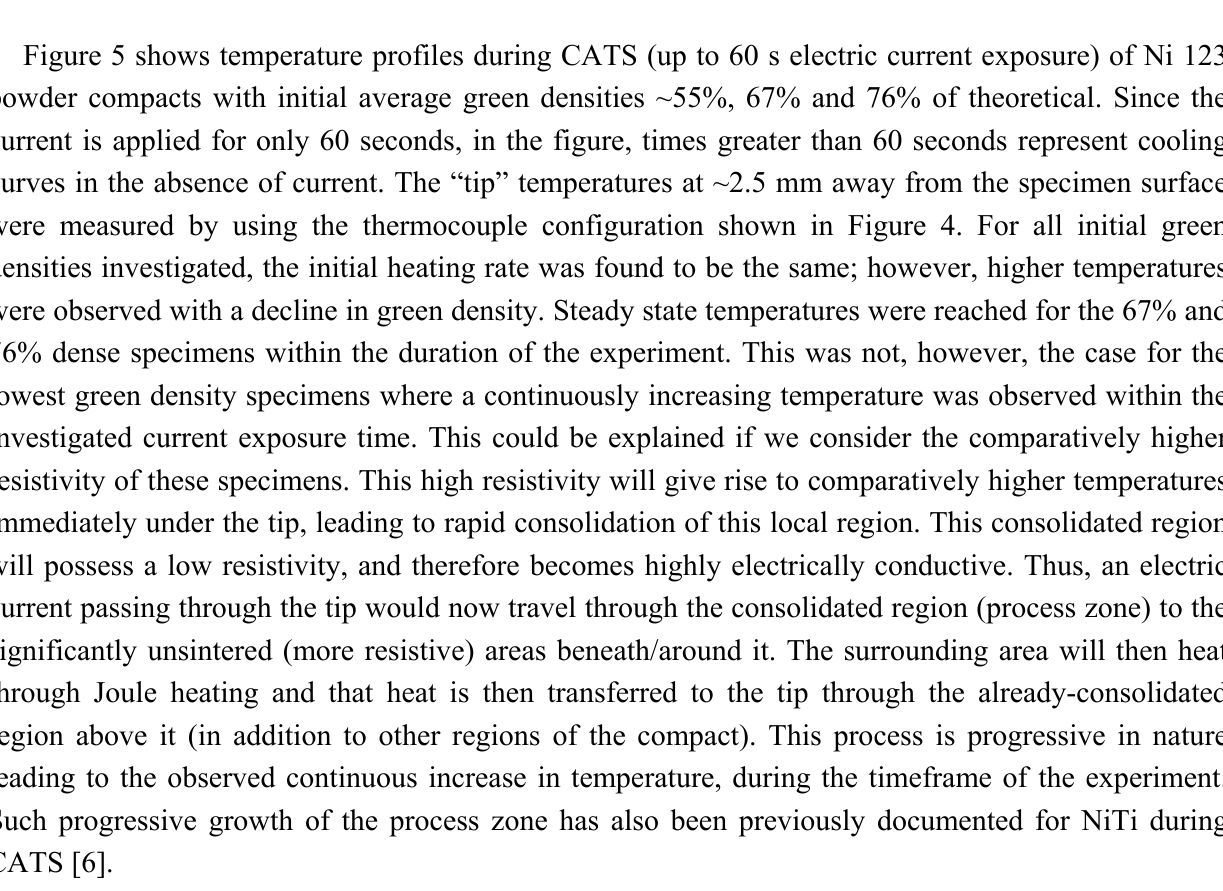
Figure 5. Temperature measurements taken from a thermocouple cemented on the CATS tip (~2.5 mm away from tip–powder compact